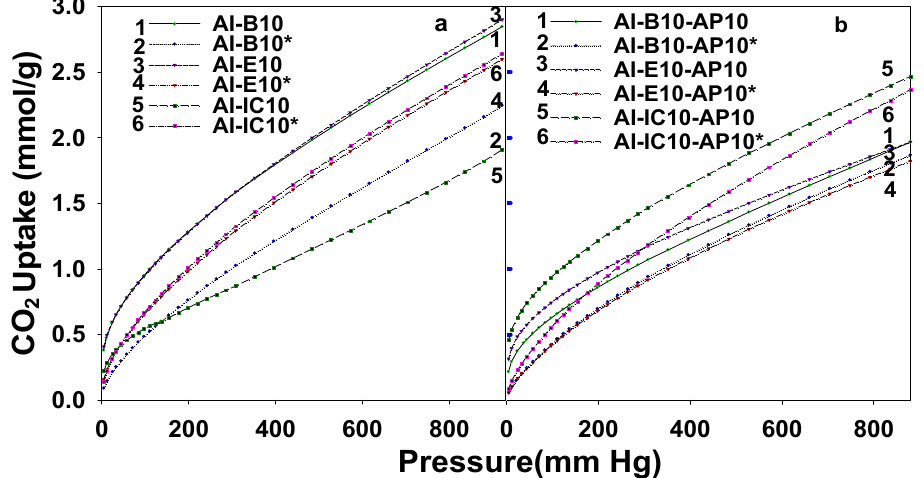
Figure 12. CO 2 adsorption profiles at 25 °C measured on the extracted, and extracted and calcined (*) ( a ) AN-Z10 and ( b ) AN-Z10-AP10 samples, where Z = B, E, or IC.